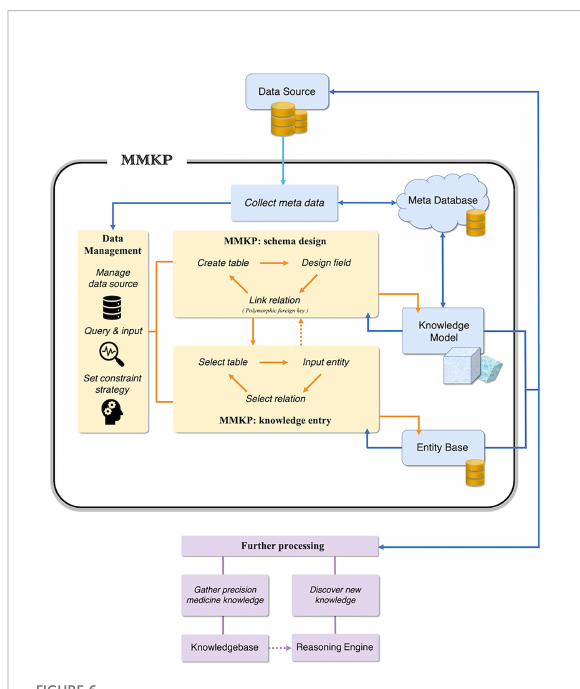
FIGURE 6 The schematic design of MMKP. MMKP applies a cyclic schema to model the precision knowledge and enter content, which supports alternative curation and revision of the knowledge structures and knowledge content. MMKP stores models and entities in the inner meta-database and entity base, keeping user operations independent of the data source before